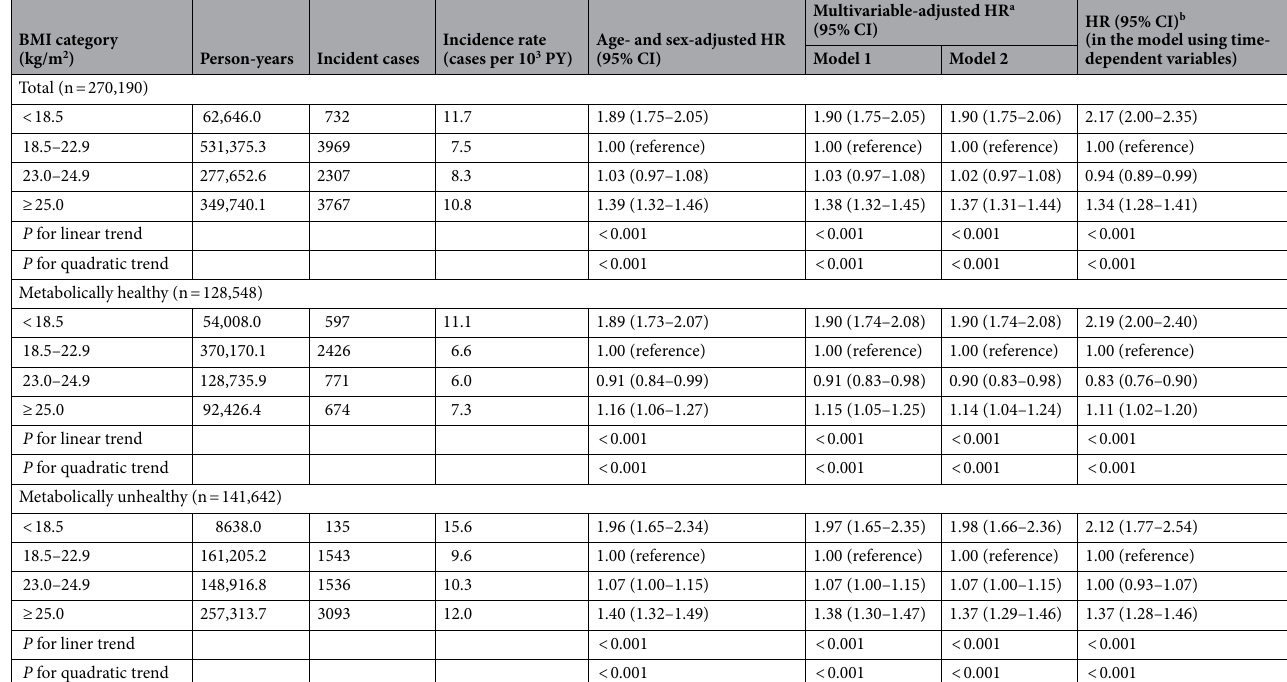
Table 2. Development of restrictive lung diseases by body mass index category in metabolically healthy and unhealthy phenotypes. P = 0.001 for the overall interaction between metabolic health status and BMI category for incident restrictive lung diseases (adjusted model 1). a Estimated from parametric proportional hazard models. Multivariable model 1 was adjusted for age, sex, centre, year of screening examination, education level, smoking status, alcohol intake, physical activity level, and total energy intake; model 2: model 1 plus adjustment for eosinophil count and high-sensitivity C-reactive protein level. b Estimated from parametric proportional hazard models with BMI category, smoking status, alcohol intake, physical activity level, and total energy intake as time-dependent categorical variables and baseline age, sex, centre, year of screening examination, and education level as time-fixed variables. BMI body mass index, CI confidence interval, HR hazard ratio, PY person